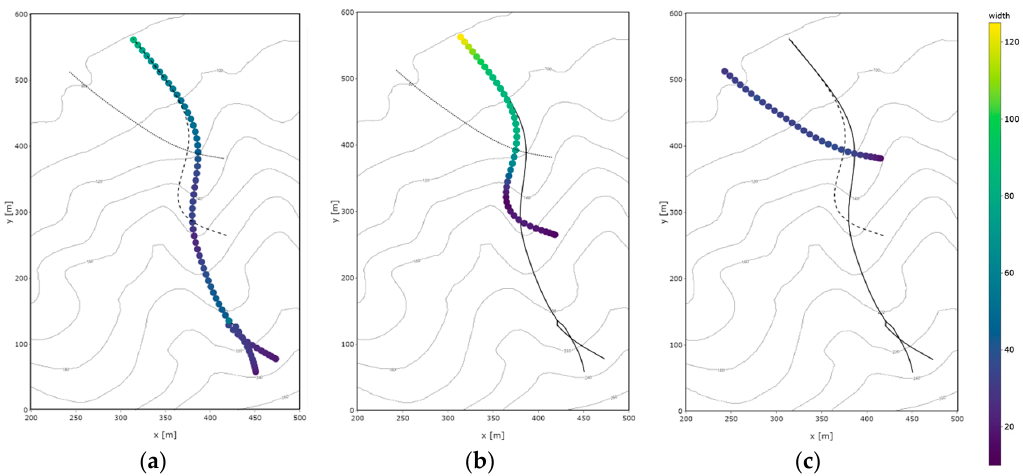
Figure 15. The hazard assessment map generated from the developed framework showing the width (unit: m) of the debris-flow cluster for ( a ) flowpath A, ( b ) flowpath B, and ( c ) flowpath C. The flowpaths are plotted separately for clarity.